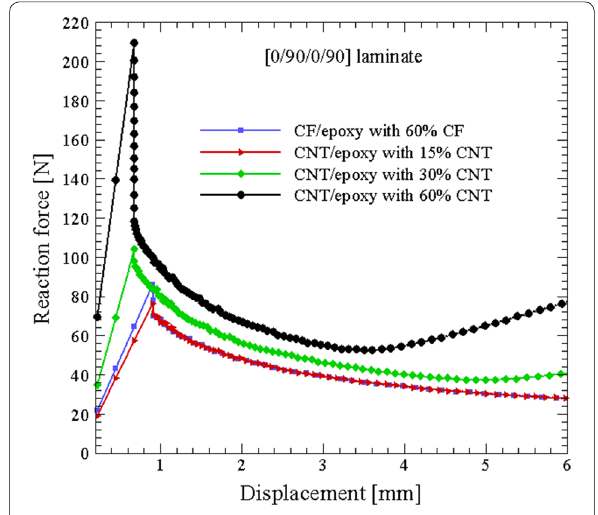
Fig. 11 Variation of reaction force with displacement at different fibre volume fractions for [0/90/0/90] stacking sequence of laminate